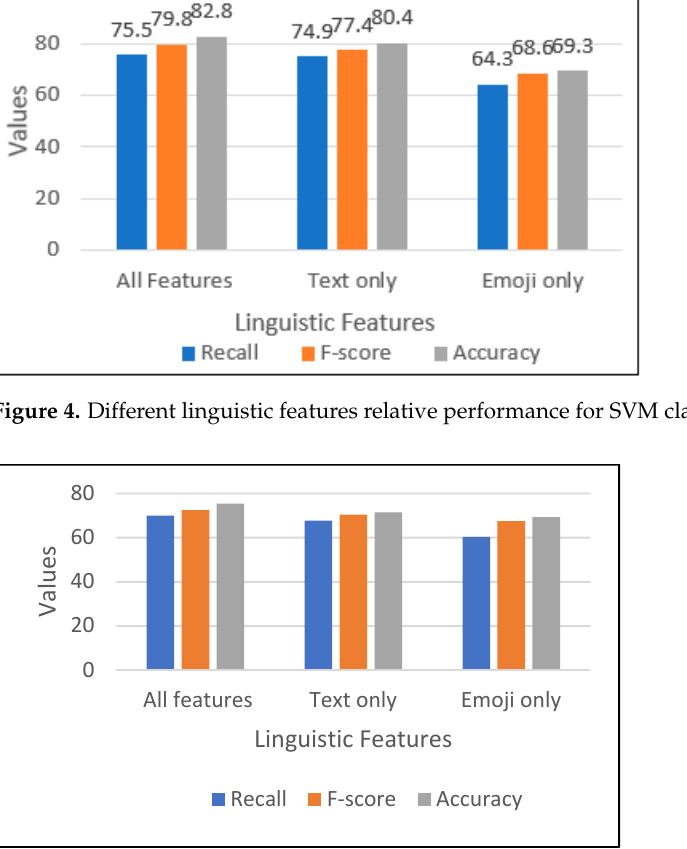
Figure 5. Relative performance of different linguistic features for Naïve Bayes classifier.